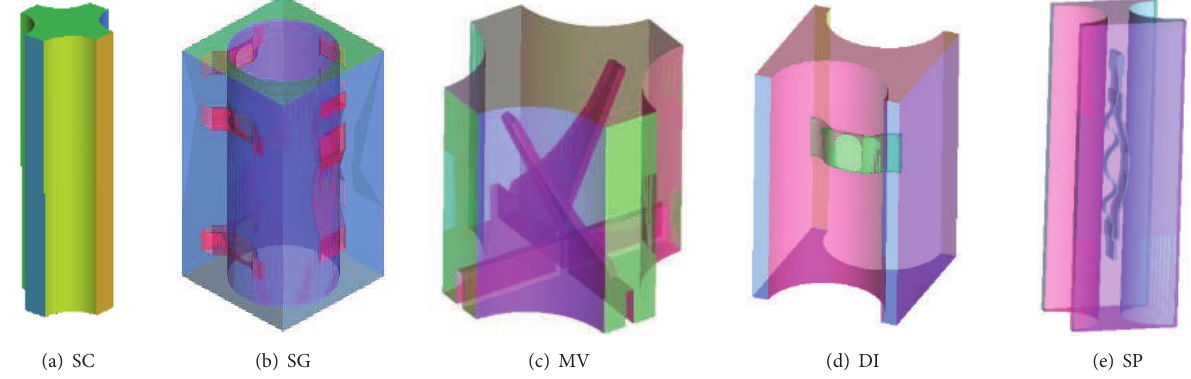
Figure 1: Regions for research of meshing methods.